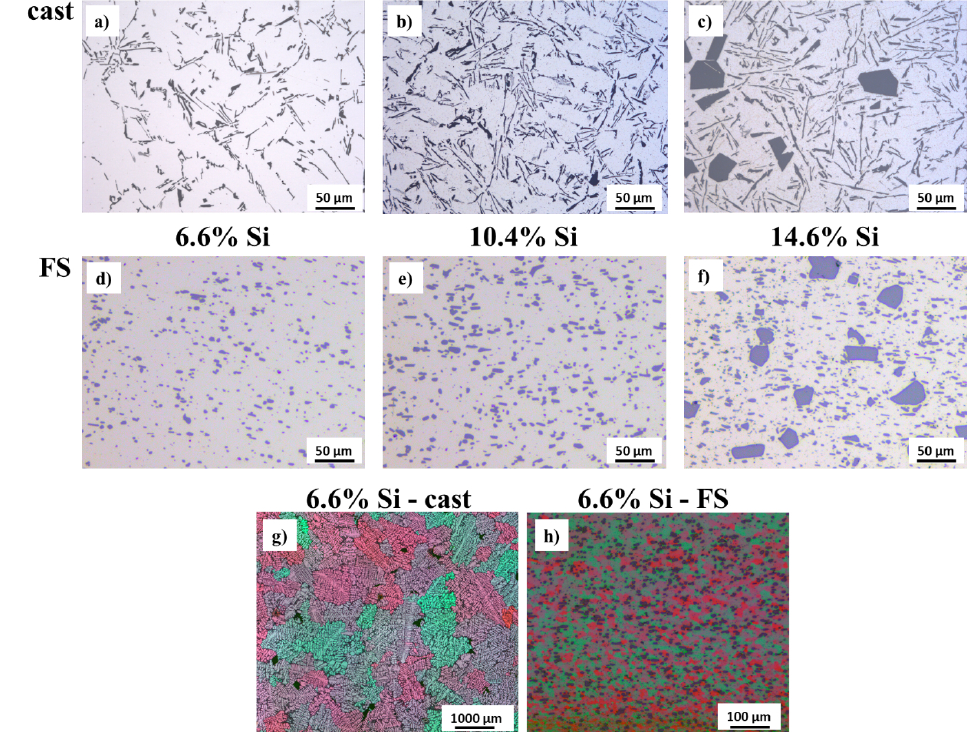
Figure 5. Light microscopic images showing the microstructure of the Al alloys. As-cast state: ( a , b ) hypoeutectic, Si needles; ( c ) hypereutectic, Si needles, Si primary phase particles. FS coatings: ( d , e ) hypoeutectic, fine dispersed Si particles; ( f ) hypereutectic, fine dispersed Si particles, Si primary phase particles. After electrolytical etching observed under polarized light 6.6% Si alloy: ( g ) as-cast-